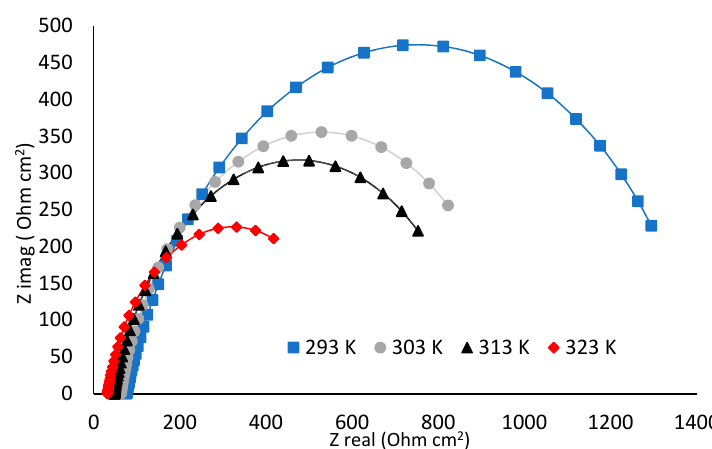
Figure 4. Nyquist diagrams for API-X120 steel in GTL process water solution determined experimentally (point line) and fitted ones (solid lines) at different temperatures.